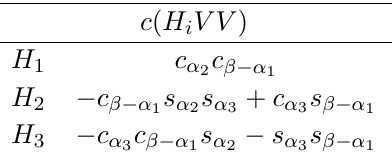
Table 1 . The e(cid:11)ective couplings c ( H i V V ) of the neutral CP-even N2HDM Higgs bosons H i to the massive gauge bosons V = W; Z .